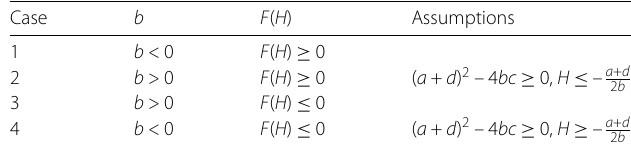
Table 1 Situations matching Theorem